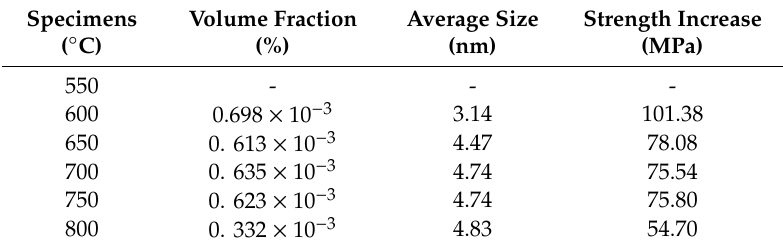
Table 3. The strengthening contribution of